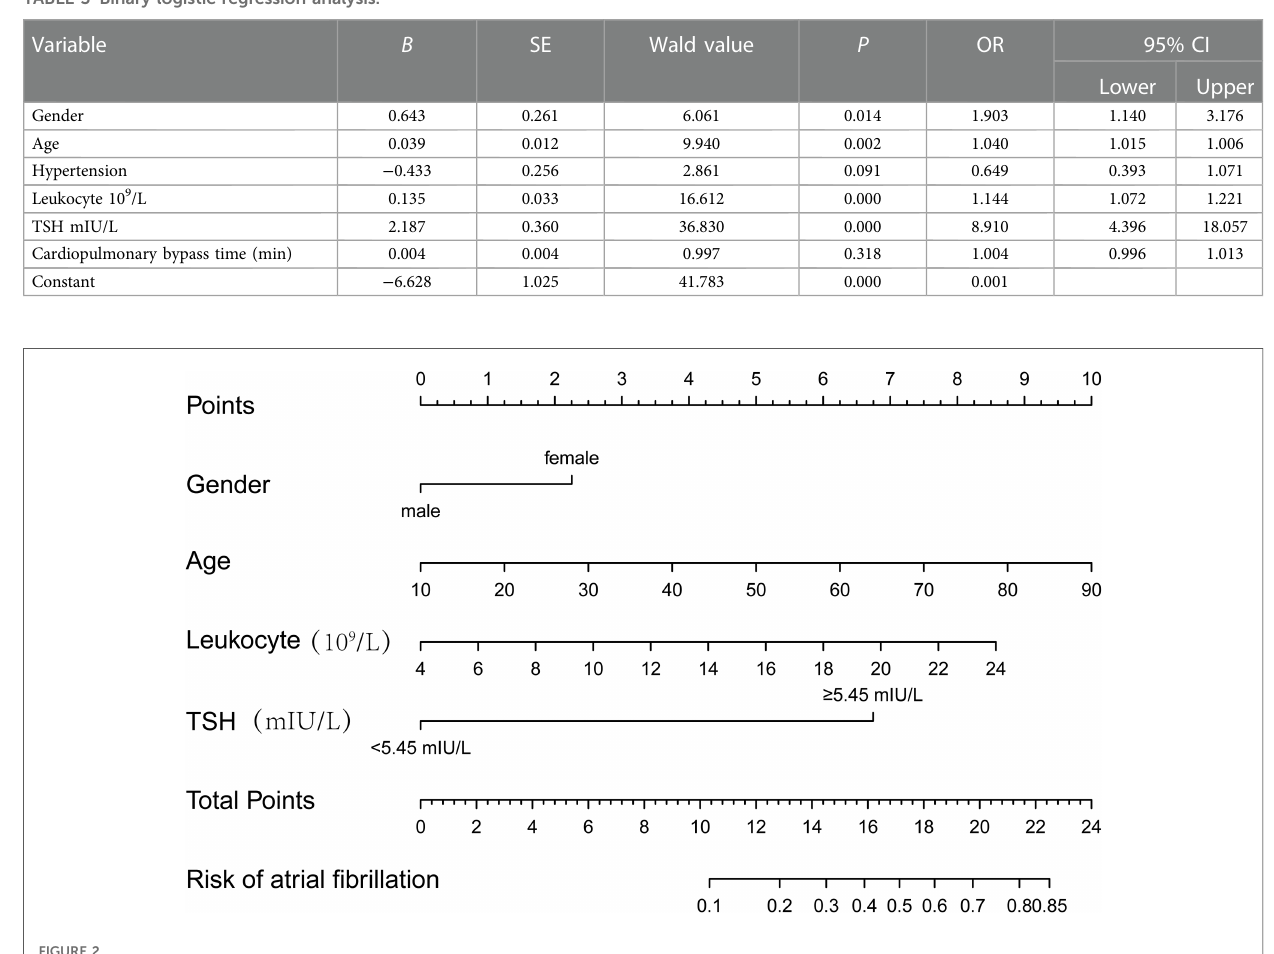
FIGURE 2 POAF risk prediction line graph model.